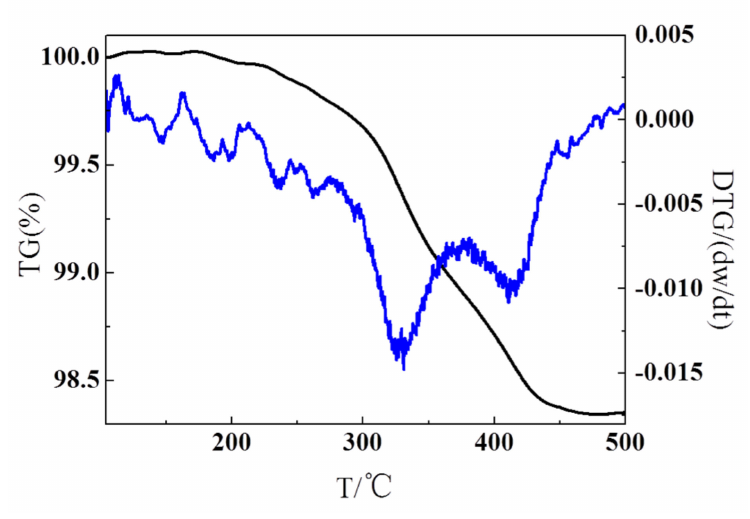
Figure 5. TG-DTG analysis of PCNS@PVP / Mg powder